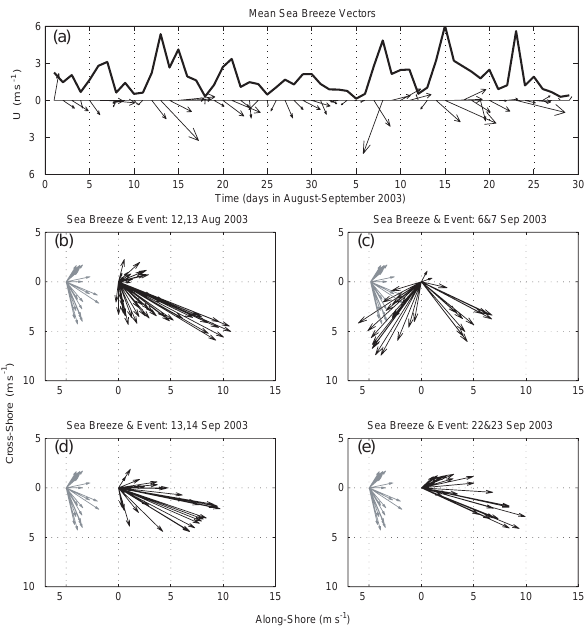
Fig. 3. (a) Mean sea breeze vectors over 25h period (1. Sect. of data); (b) storm event: 12, 13 August 2003; (c) storm